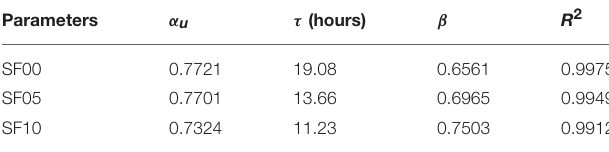
TABLE 5 | Kinetic parameters in Equation (20) obtained from non-linear